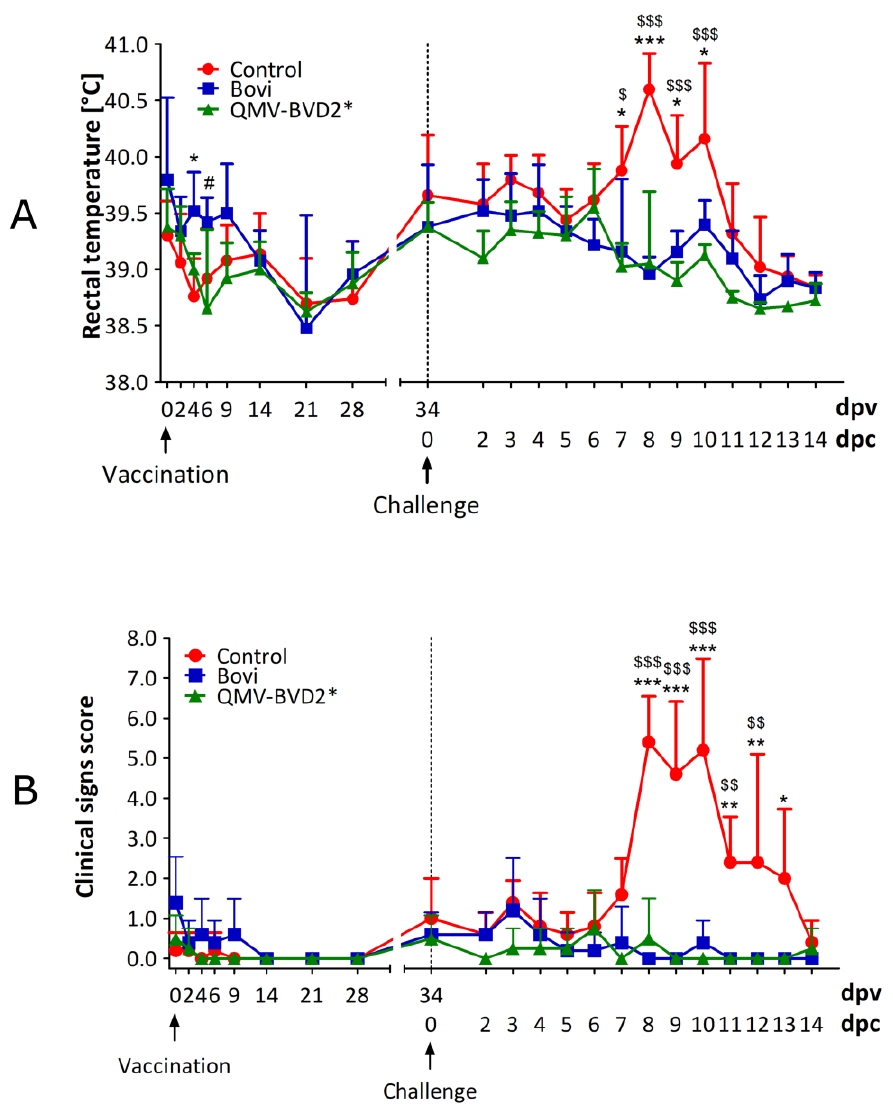
Figure 10. Clinical assessments. ( A ). Rectal temperature of calves following vaccination and challenge. Rectal temperature was measured with a digital thermometer on the indicated days. Shown is the mean temperature of each treatment group with SD. The data represent the mean + standard deviation. Significant differences in rectal temperature were seen between different groups. n = 5 (QMV–BVD2* group contained 4 animals); Two–way ANOVA followed by Bonferroni post–tests to compare replicate means by row; * p < 0.05, *** p < 0.001 between Control and Bovi group. # p < 0.05 between Bovi and QMV–BVD2* group. $ p < 0.05, $$$ p < 0.001 between Control and QMV–BVD2* group. ( B ). Clinical scores in calves of each treatment group following vaccination and after BVDV–2 challenge is shown. According to a scoring system reported earlier [42], minor modifications are listed in Table S1. Shown is the mean of each group with SD. Significant differences in clinical Two–way ANOVA followed by Bonferroni post–tests to compare replicate means by row; * p <